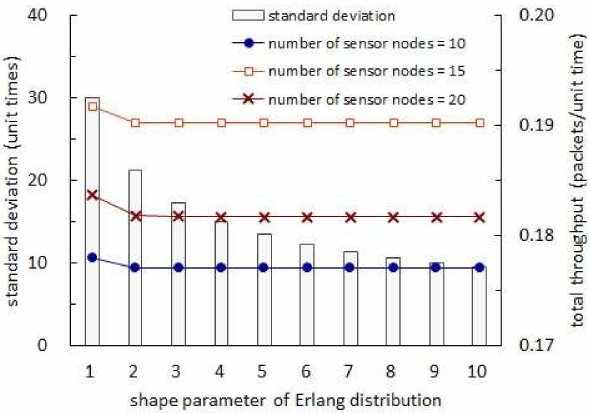
Figure 10. Total throughput and standard deviation with respect to shape parameter of Erlang